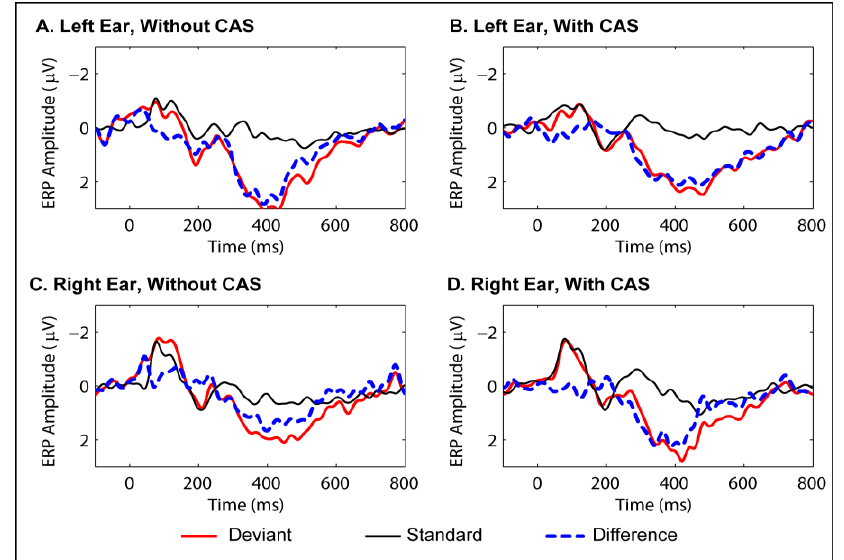
Figure 3. Grand average waveforms for ERP responses to standard and deviant stimuli in the active discrimination (P300) condition and the difference between the two (deviant–standard). Waveforms were averaged across central, mid-central, parietal and mid-parietal sites. Panel ( A ): left ear, no contralateral acoustic stimulation (CAS). Panel ( B ): left ear, with CAS. Panel ( C ): right ear, no CAS. Panel ( D ): right ear, with CAS. Table 5. Descriptive statistics of peak amplitudes and peak latencies of MMN and P300 in the two conditions in the two ears. Please see text for sites grouped for analysis. CAS = Contralateral Acoustic Stimulation, µ V = micro Volts, ms = milliseconds, SD = Standard Deviation.